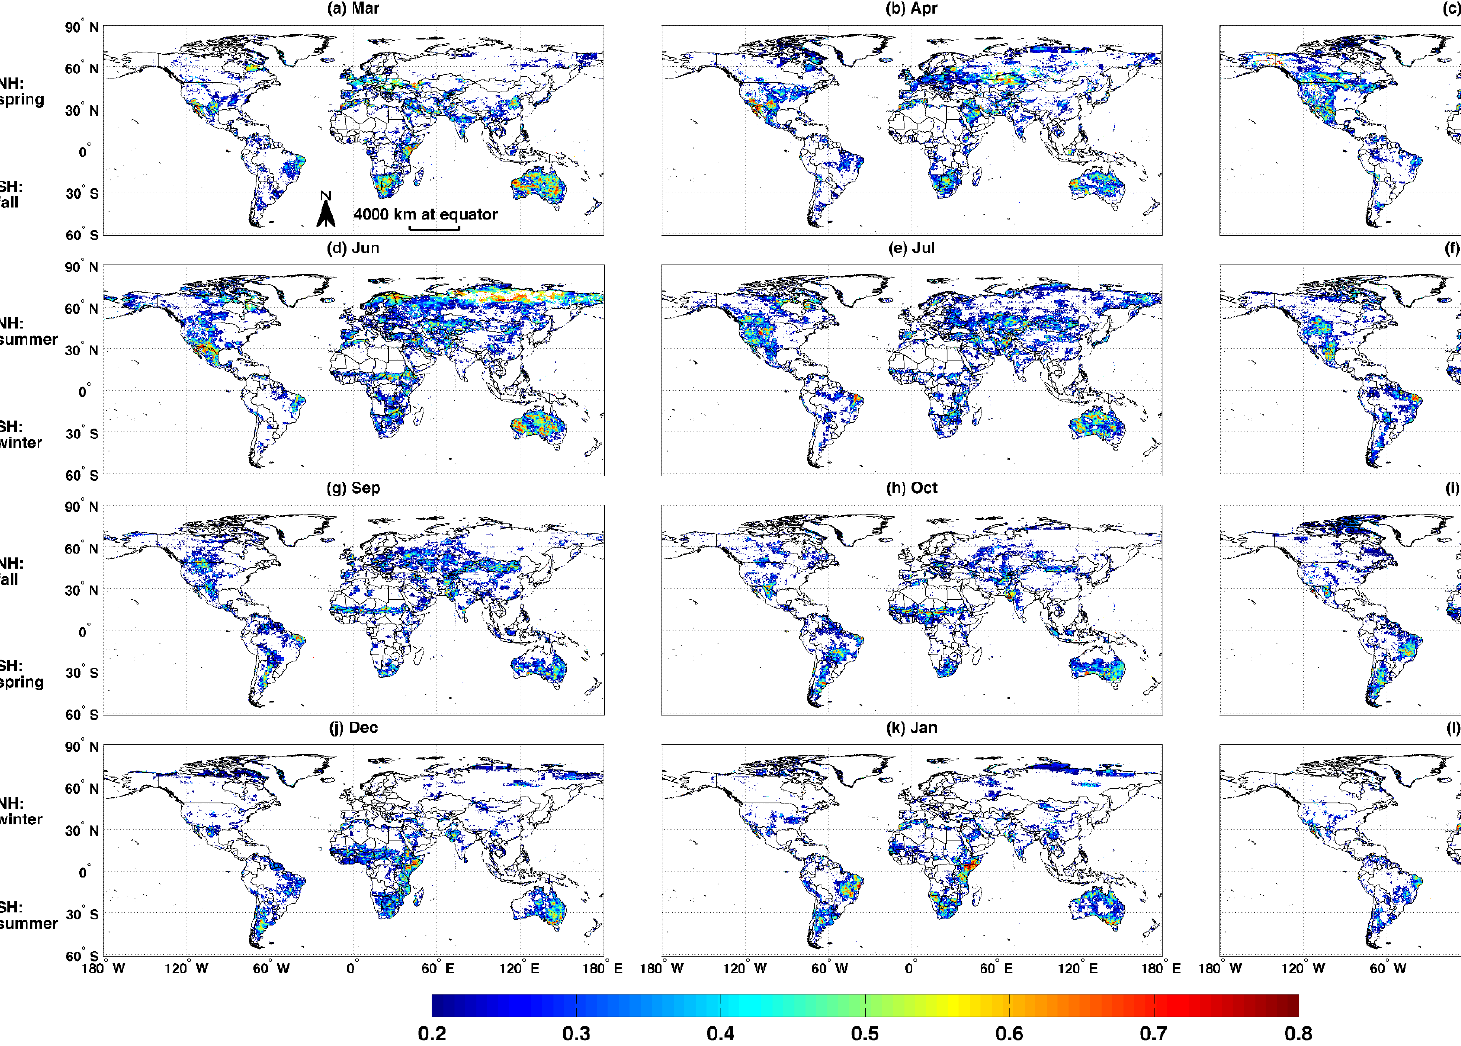
Figure 9. Fraction of NDVI variance explained ( R 2 ) by climate (cumulative precipitation for lead 1–6 and temperature at lead 0 corrected for snow interference, both positively correlated with NDVI with p < 0.05, 1982–2010) for the 12 months of the year ( a – l ) (Spatial resolution: